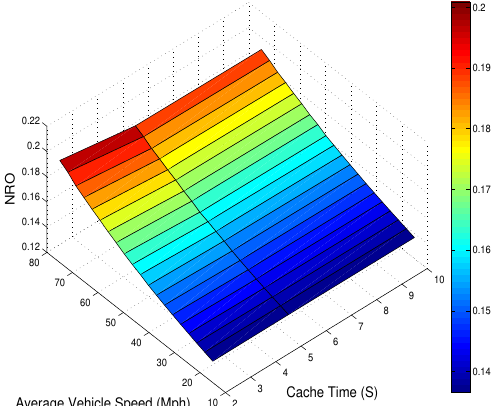
Figure 8. Normalized routing overhead vs. 2 s, 5 s, 10 s Cache Time and Average Vehicle Speed (Mph).